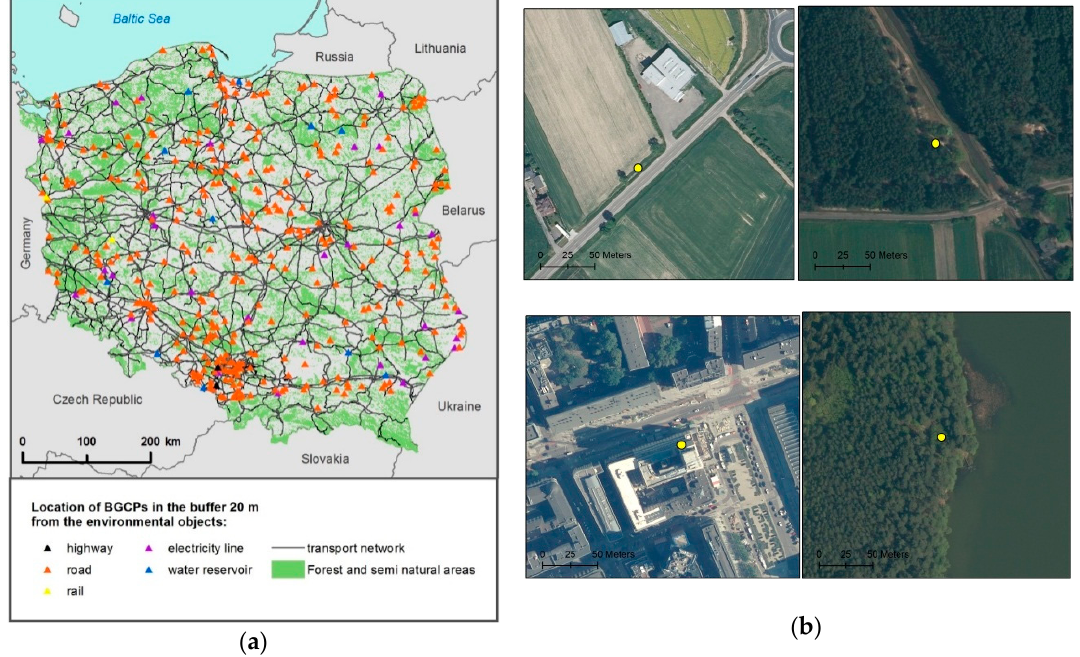
Figure 4. Poland: ( a ) BGCPs located in near vicinity of express roads, water reservoirs, or electricity lines; ( b ) zoom to selected BGCPs exposed to signal disruption (upper left express road, upper right electricity line, bottom left—dense urban, bottom right—forest and water reservoir).